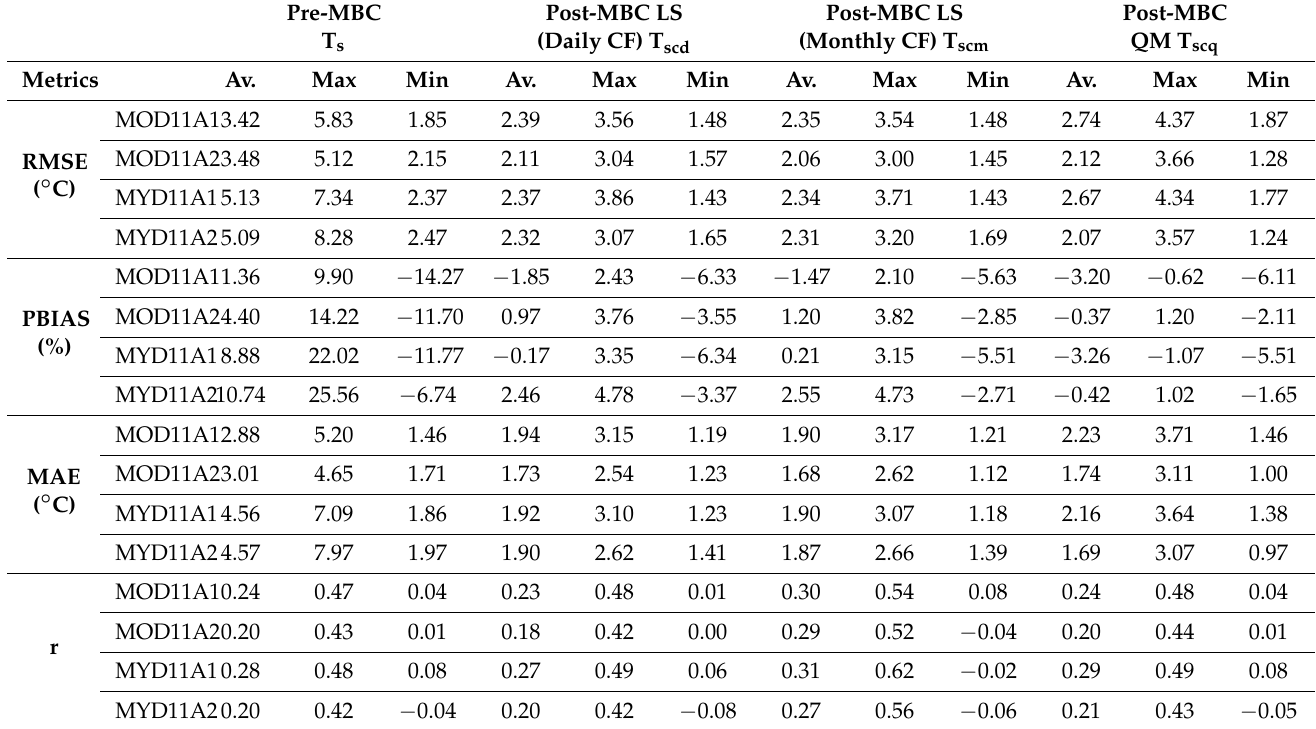
Table 3. RMSE, MAE, PBIAS, and r for pre-MBC (T s ), post-MBC linear scaling using constant daily CF (T scd ), post-MBC linear scaling using monthly CF (T scm ), and post-MBC quantile mapping (T scq ) against T a according to the leave-two-years- out evaluation for 36 AWS